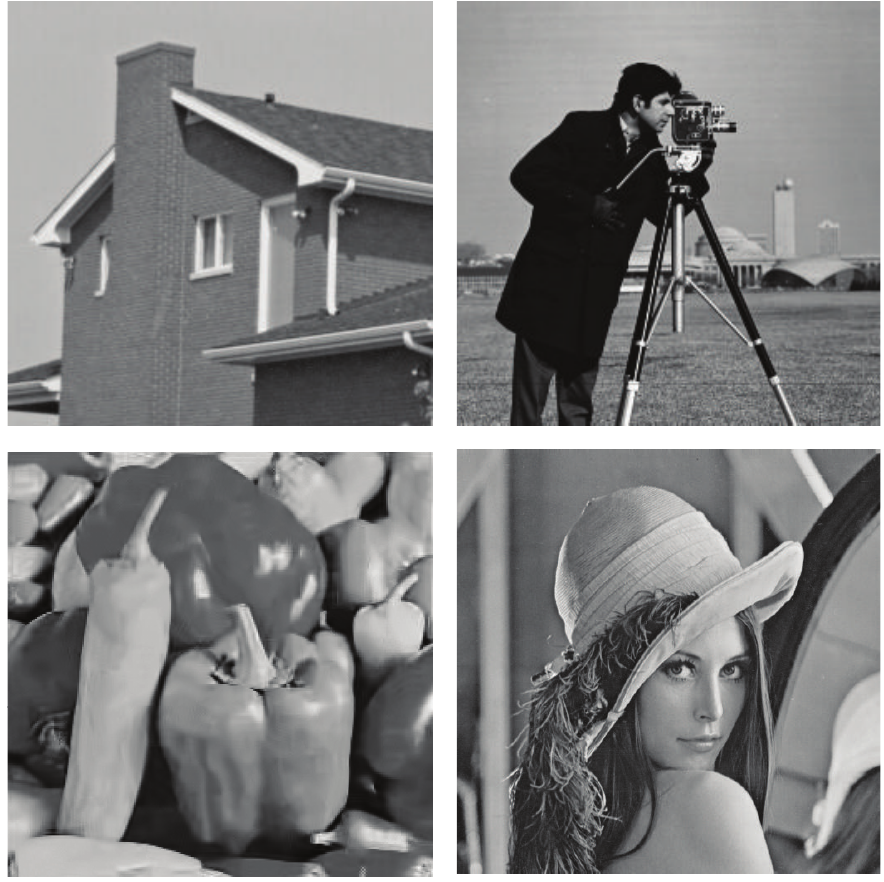
Figure 3: The test images